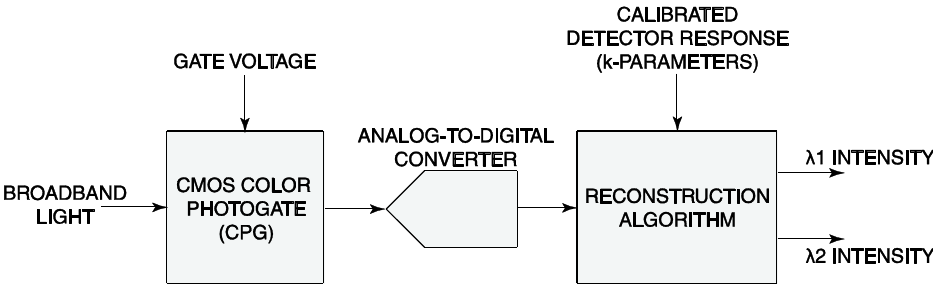
Figure 5. System diagram of the CMOS multispectral